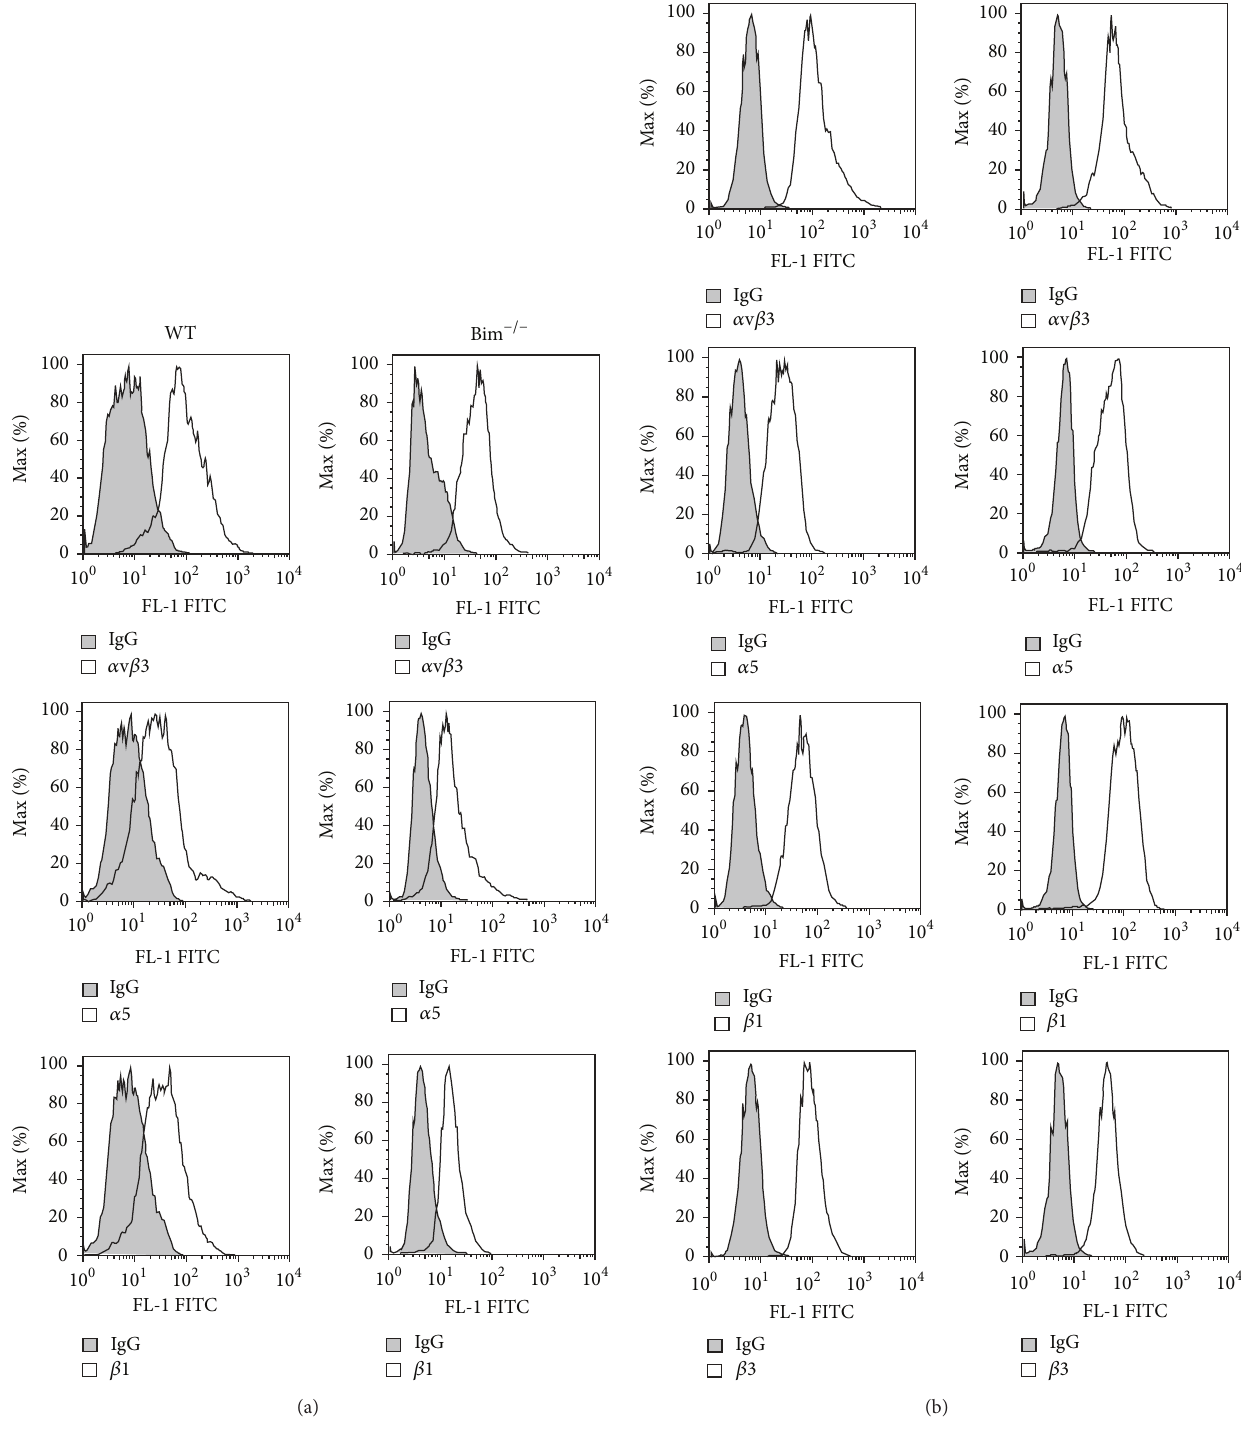
Figure 5: Wild-type and Bim −/− retinal vascular cells had similar integrin expression. Expression of various integrins was determined in wild-type and Bim −/− endothelial cells (panel (a)) and pericytes (panel (b)) using FACScan analysis as described in Section 5. The shaded graphs show staining in the presence of control IgG. These experiments were repeated twice with similar